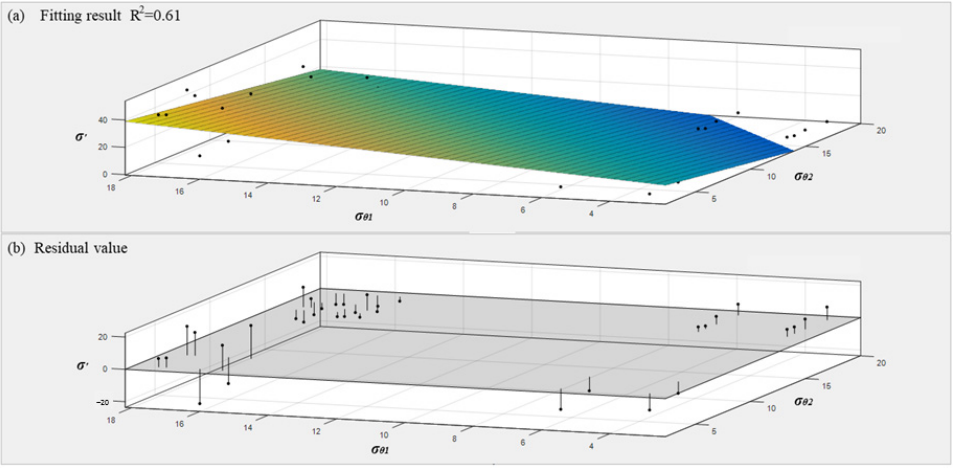
Figure 17. Fitting results.